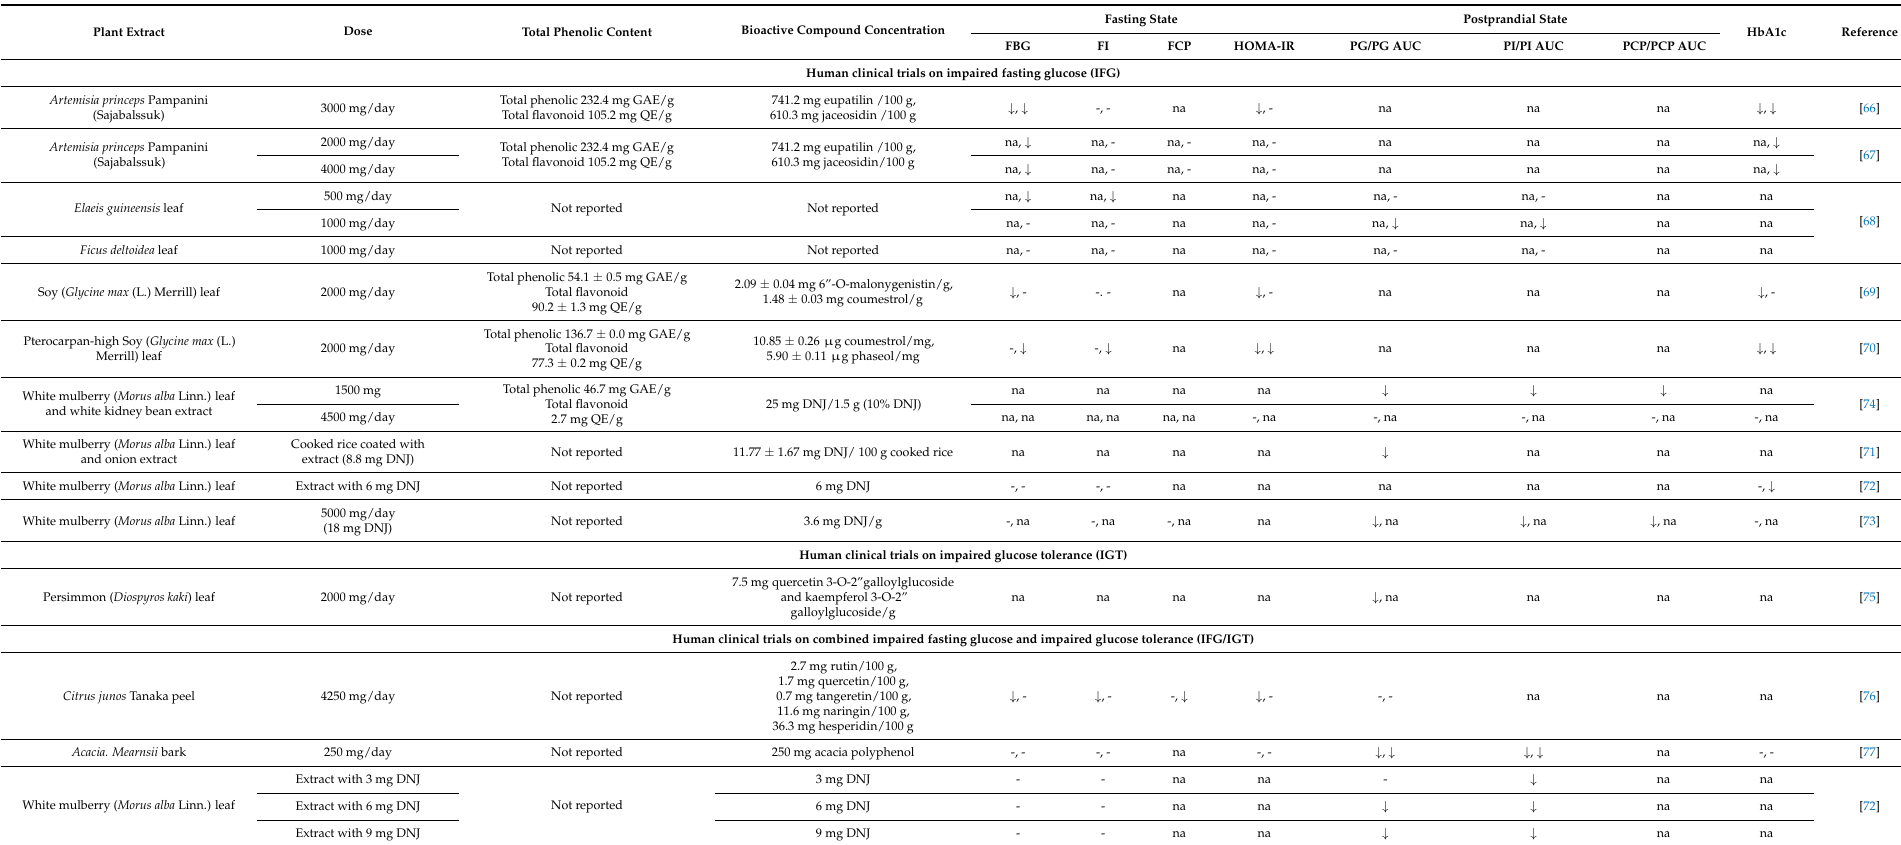
Table 2. Changes in glycemic clinical outcomes of human clinical trials in participants with prediabetes classified by their subgroups. The significant outcomes are presented in sequence first as comparison with control, then comparison within intervention